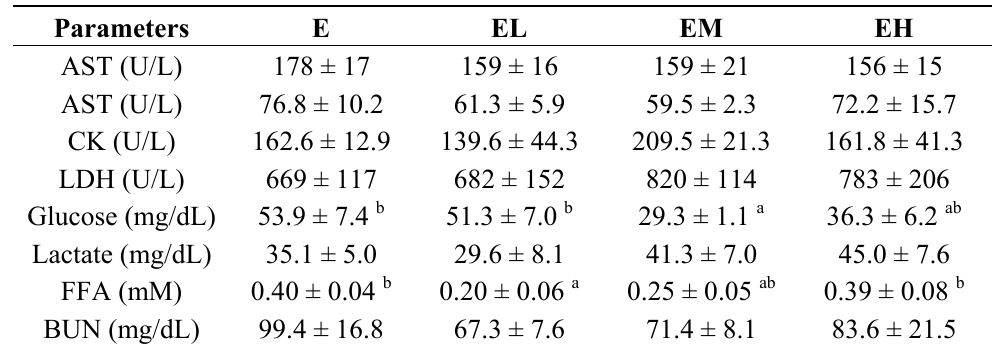
Table 2. Biochemical analysis of the G. tsugae treatment groups after an exhaustive treadmill exercise challenge.